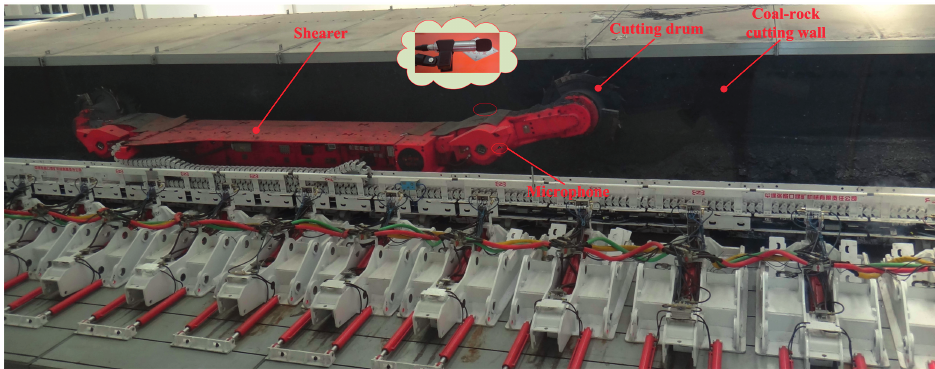
Figure 3. The experimental